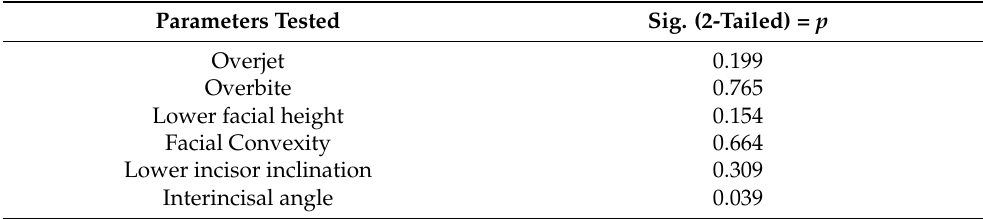
Table 7. p results for the independent t -tests comparing string and wind groups.